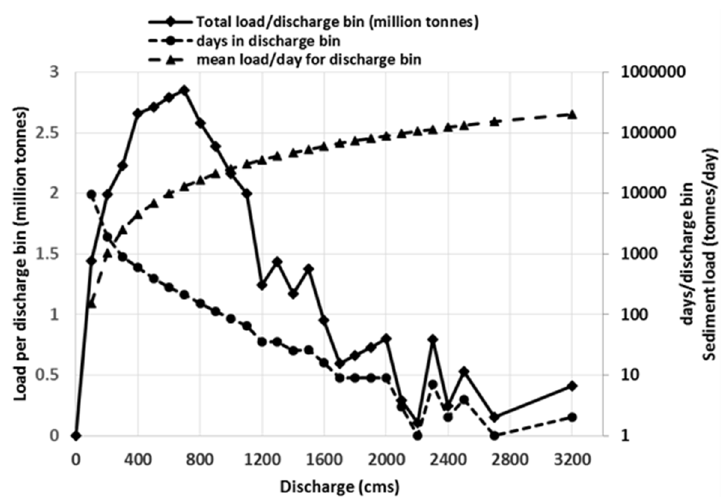
Figure 1. Illustration for the Maumee River, Ohio, that the effective discharge, 700 m 3 /s, carries the largest total sediment load based on 14,415 days of discharge and suspended load data from 1950 to 1993 (cms = m 3 /s). Powell et al. [11].